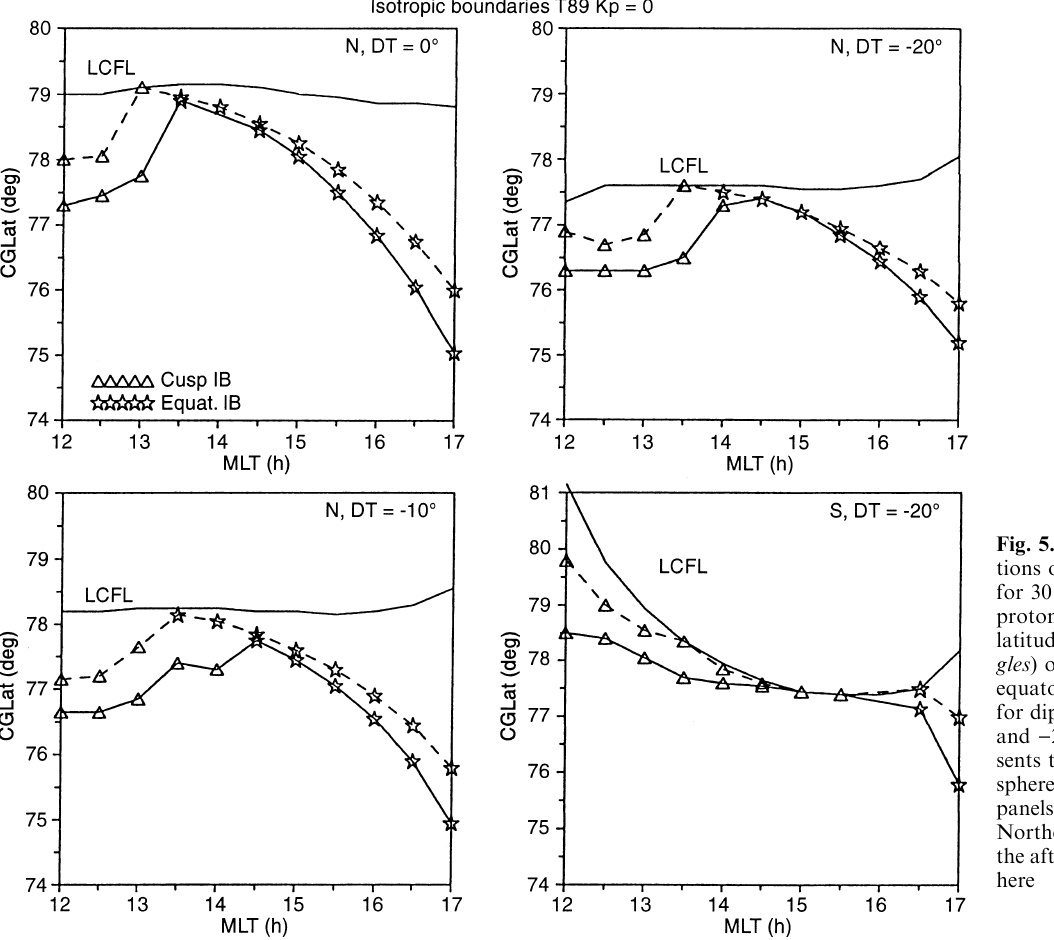
Fig. 5. Ionospheric projec- tions of isotropic boundaries for 30 keV and 80 keV protons scattered in the high- latitude cusp region ( trian- gles ) or in the nightside equatorial region ( asterisks ) for dipole tilt angles 0 (cid:176) , ) 10 (cid:176) and ) 20 (cid:176) . Lower left repre- sents the Southern Hemi- sphere whereas other three panels correspond to the Northern Hemisphere. Only the afternoon sector is